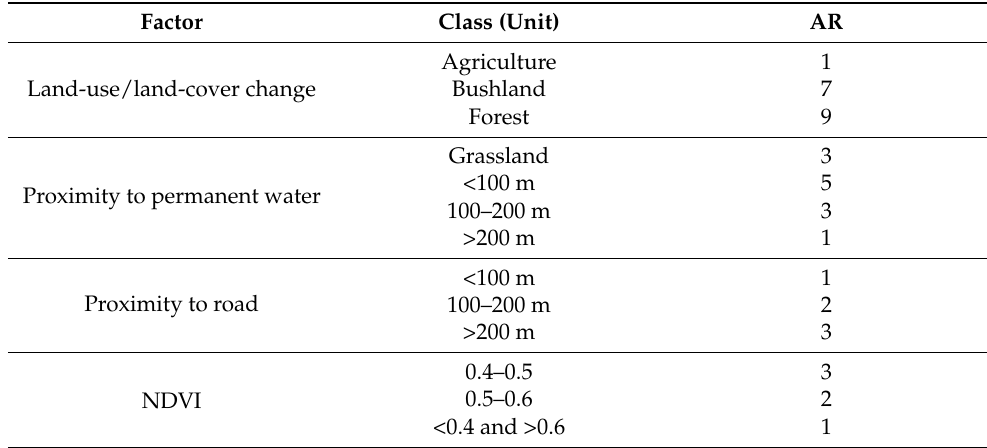
Table 2. Assigned ranked values based on the various factors that might impact elephant